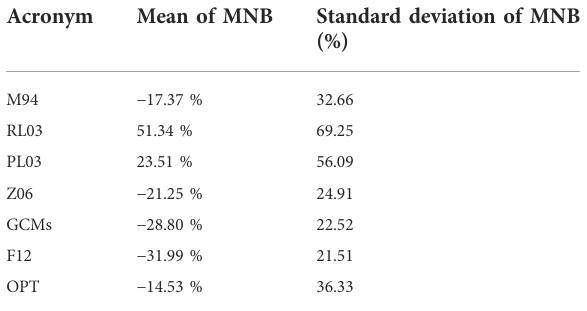
TABLE 3Statisticsoftheperformanceoftheclosurestudyof N d sat_ N d for each β - expression used: OPT, RL03, M94, Z06, PL03, GCMs, and F12.